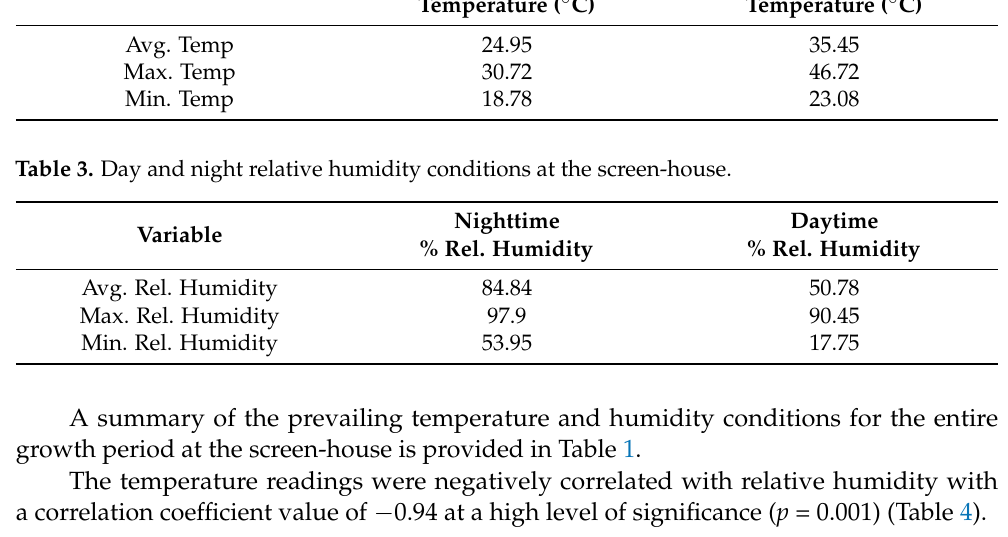
Table 2. Day and night temperature conditions at the screen-house. Variable